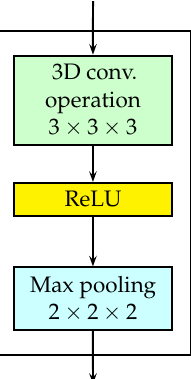
Figure 2. The detailed sturcture of a 3D convulutional layer